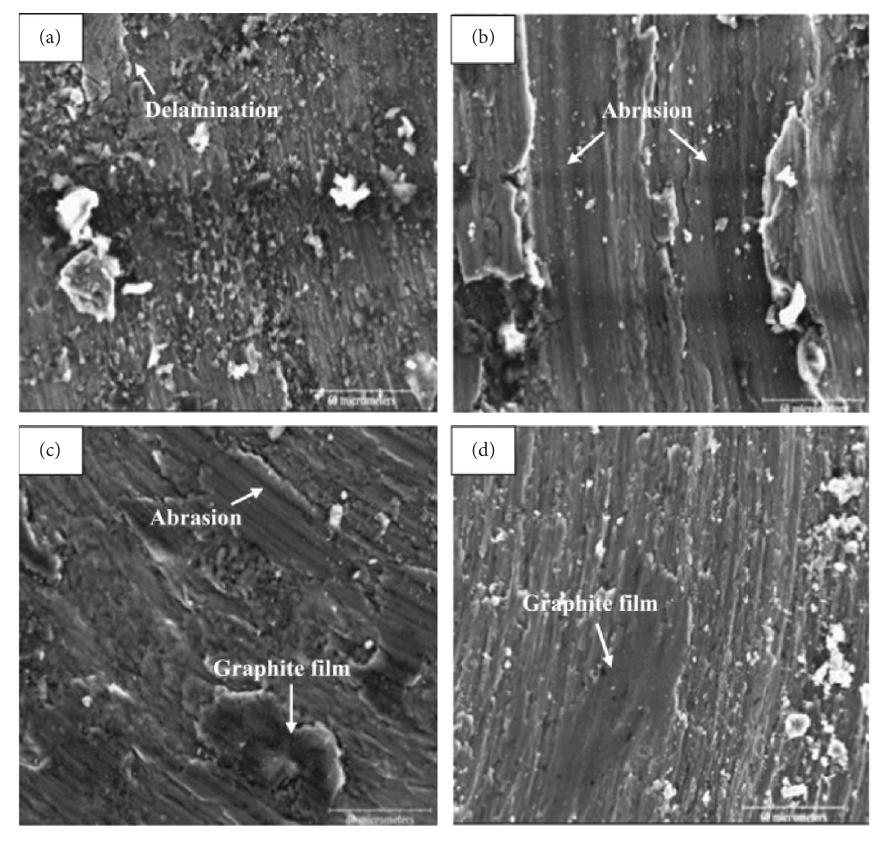
Figure 6: Typical SEM micrographs of the worn surfaces of (a) Al/2SiC, (b) Al/2SiC/2Gr, (c) Al/2SiC/5Gr, and (d) Al/2SiC/7Gr hybrid nanocomposites [69–72].